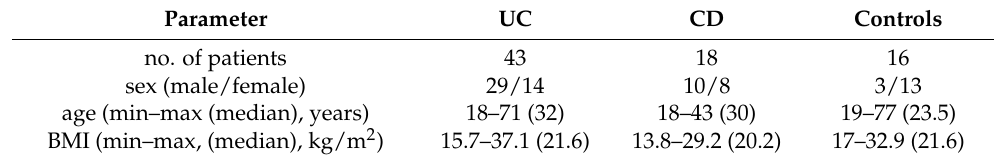
Table 1. Characteristics of patients with ulcerative colitis (UC), Crohn’s disease (CD), and controls. Parameter UC CD